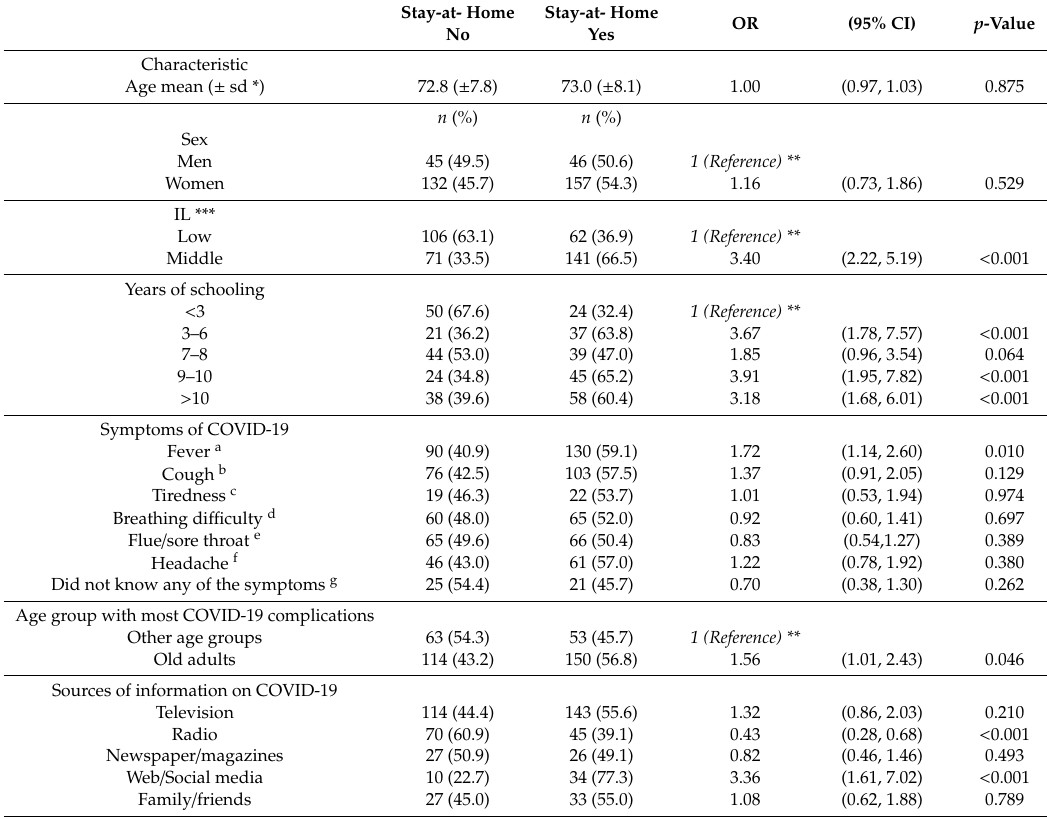
Table 3. Odds ratios of stay-at-home behavior and sociodemographic characteristics, knowledge and sources of information of the COVID-19 pandemic for adults ( ≥ 65 years old) in Mexico City. Stay-at- Home Stay-at- Home No